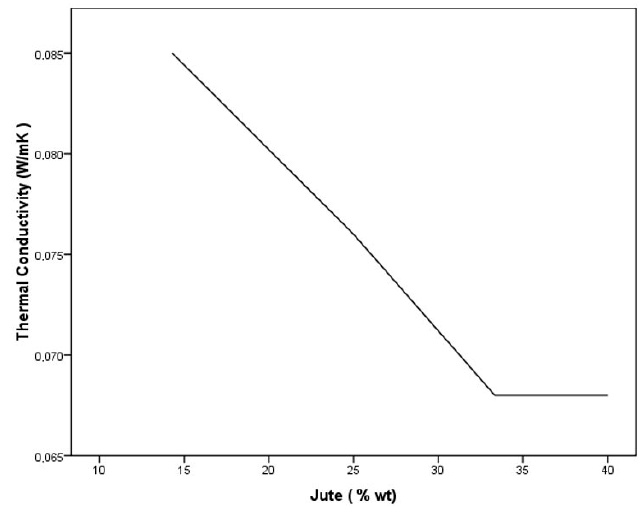
Figure 7. Thermal conductivity according to wt % of jute in the boards.